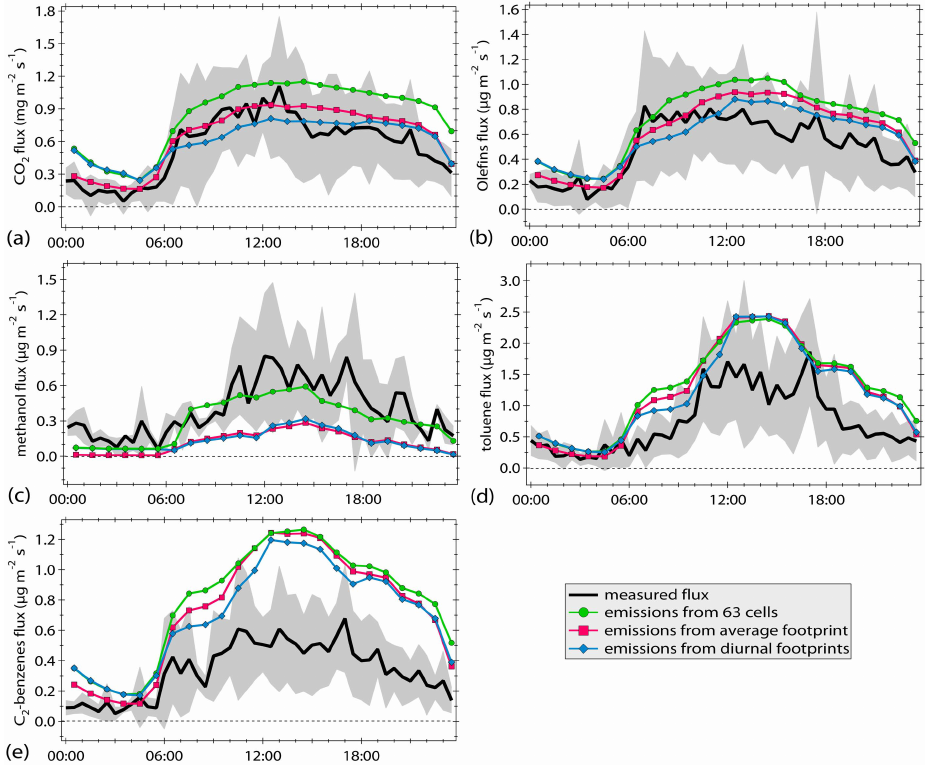
Fig. 8. Comparison of the diurnal profiles of fluxes of CO 2 (a) , olefins (b) , methanol (c) , toluene (d) , and C 2 -benzenes (e) with the diurnal profiles of emissions from the 2006 emissions inventory. The emissions were extracted from the grid cells coinciding with the footprints described in the text and the 63 surrounding cells. The gray shadows indicate ± 1 standard deviation of the measured